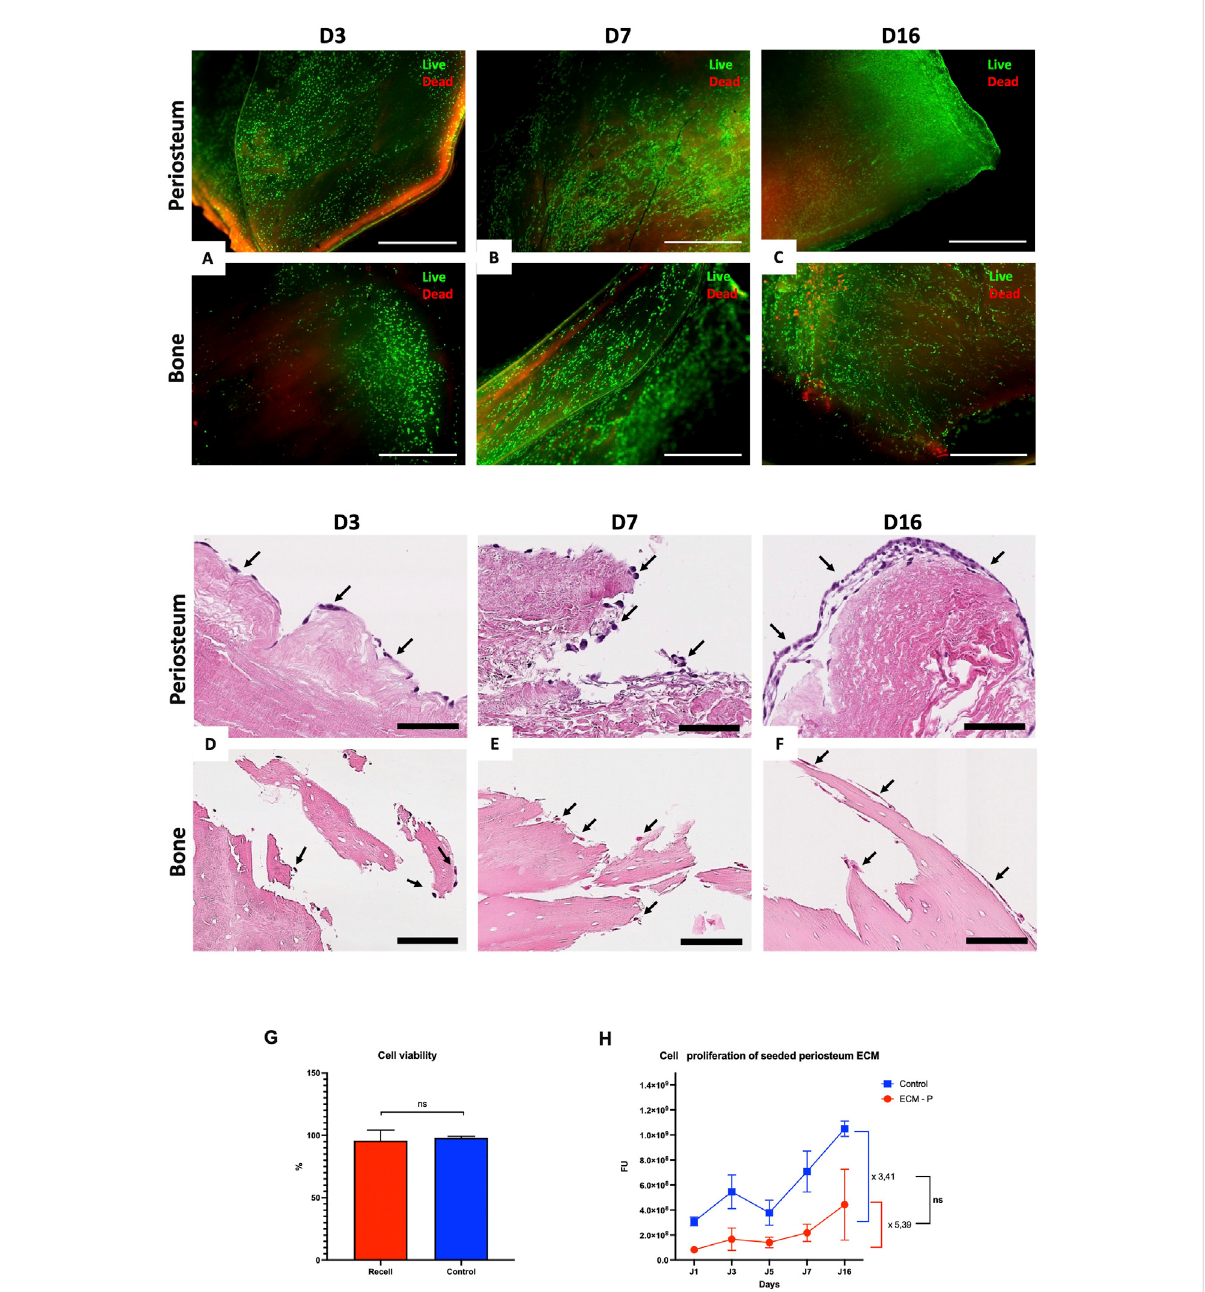
FIGURE 7 Cytocompatibility study of periosteum and bone ECM with fi broblastic cell line. (A – C) : Live/Dead staining of NIH3T3 seeded periosteum ECM (top) and bone ECM (bottom) discs after 3 (A) , 7 (B) and 16 (C) days of culture, respectively, at 2.5 x gross magni fi cation. All scale bars = 1,000 µm. (D – E) : H&E staining of NIH-3T3 seeded periosteum ECM (top) and bone ECM (bottom) after 3 (D) , 7 (E) and 16 (F) days of culture, respectively, revealingadherent fi broblasts(blackarrows)at40xgrossmagni fi cation.Allscalebars=50 µm. (G) CellviabilityanalyzedwithfourdifferentLive/ Dead images at ×2.5 gross magni fi cation of seeded periosteum and culture control wells after seven culture days (n = 3 for each group; p = 0.7987, ns = non-signi fi cant). (H) Cell proliferation rate analyzed using Prestoblue Assay during 16 days of culture (n = 3 × 2 ECM; ns = non-signi fi